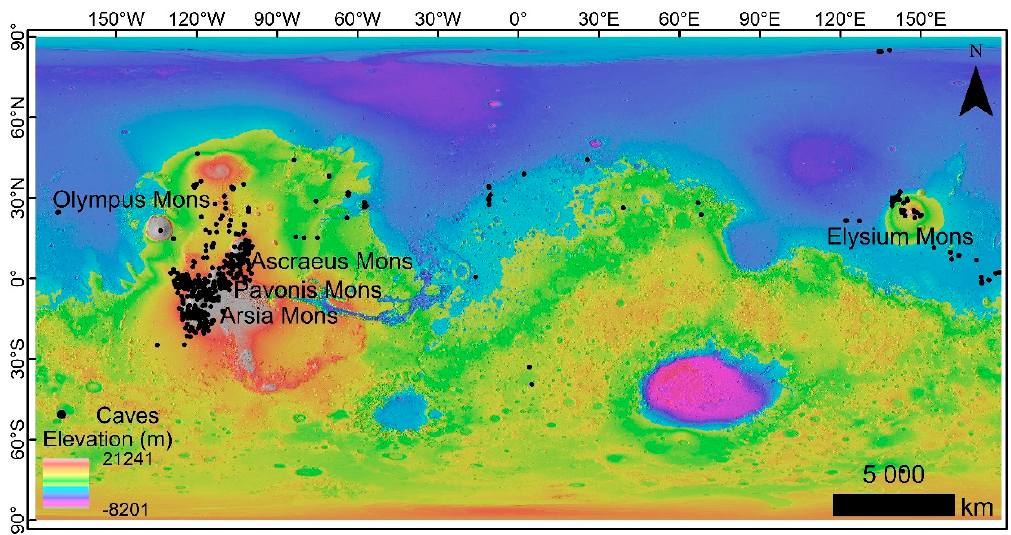
Figure 9. Global distribution of sighted possible caves on Mars. Mars Orbiter Laser Altimeter (MOLA) elevation and hillshaded view is in the background (courtesy: NASA/JPL/Goddard). The cave locations are retrieved from Mars Global Cave Candidate Catalog (MGC^3) [84].